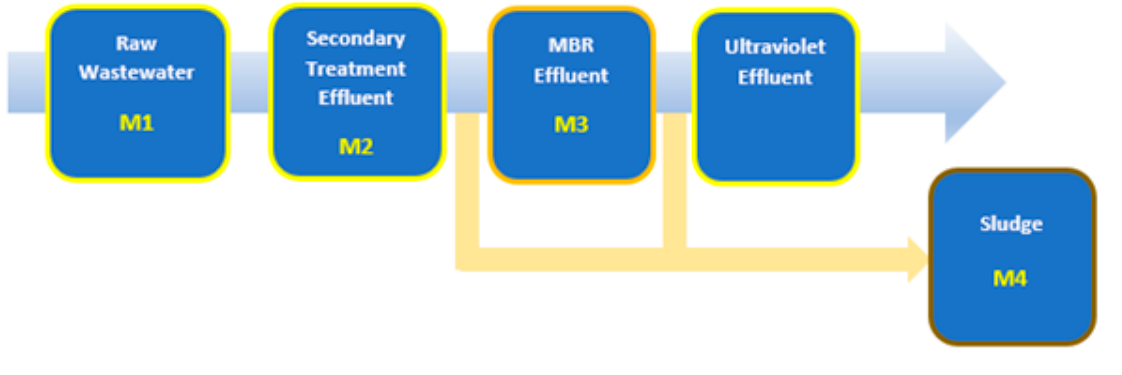
Figure 5. Control and sampling points.